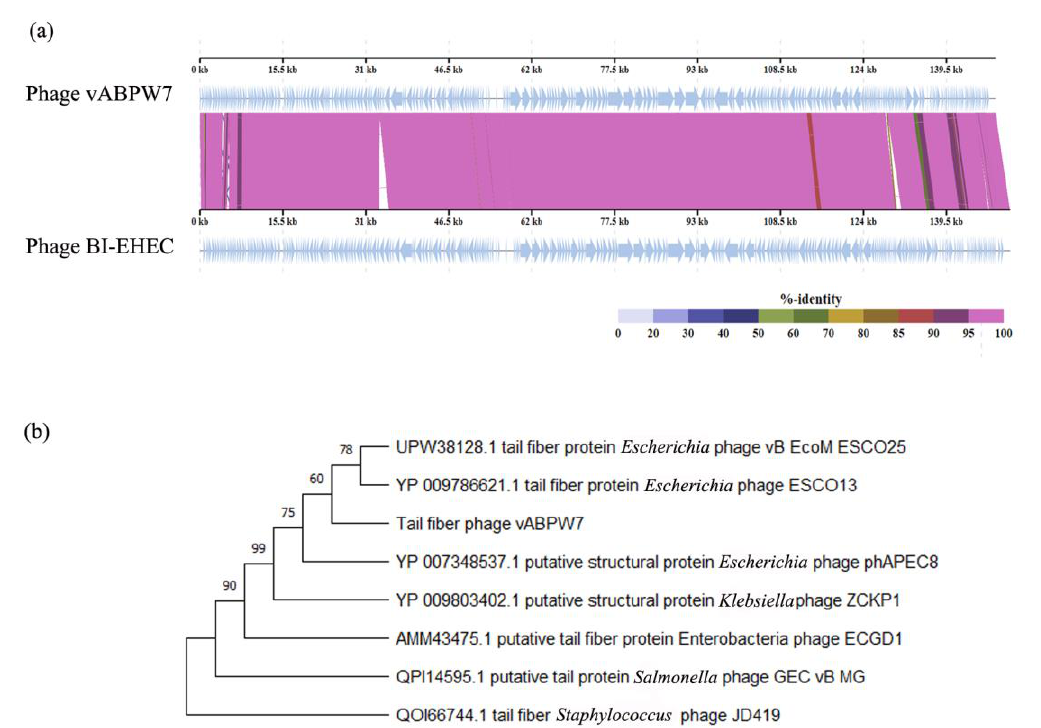
Figure 5. Genomic analysis of phage vABPW7. ( a ) A synteny plot displaying the genome structure of phage vABPW7 compared to Escherichia phage BI-EHEC, which is the most closely related phage to phage vABPW7. ( b ) A phylogenetic tree of the tail fiber protein of phage vABWU7. The multiple amino acid sequences were aligned by MUSCLE and the maximum-likelihood phylogenetic tree (JTT matrix-based model) was constructed in MEGA-X using 1000 bootstrap replicates. The tail fiber of Staphylococcus phage JD419 (QOI66744) was used as an outgroup.